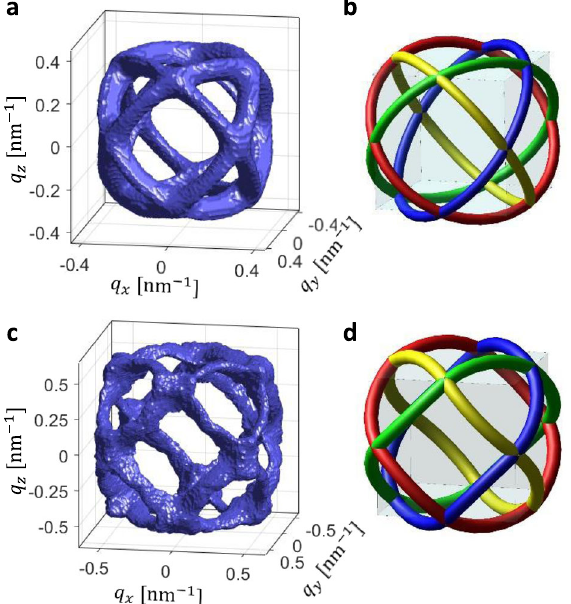
Fig. 1 A comparison of the reciprocal-space structure of the modulation wavevectors in GaV 4 S 8 and GaMo 4 S 8 . a The tomo- graphic SANS image measured at 12 K in GaV 4 S 8 and b its graphical representation. The scattering pattern contains four rings of q - vectors represented by distinct colours in ( b ), each corresponding to one of the rhombohedral domain states. c The distribution of the magnetic wavevectors observed at 2 K in GaMo 4 S 8 and d its schematic view. The rings are de fl ected from the 111 f g -type planes in the segments between the < 110 > directions in an alternating